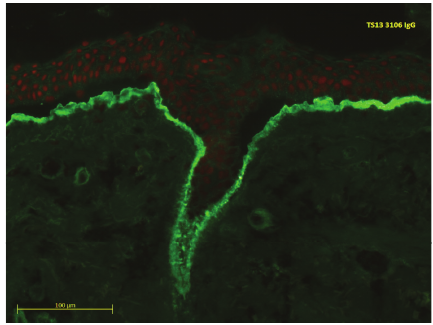
Figure 3: Direct IMF displaying linear deposition of IgG, IgA, and C3 at the basement membrane